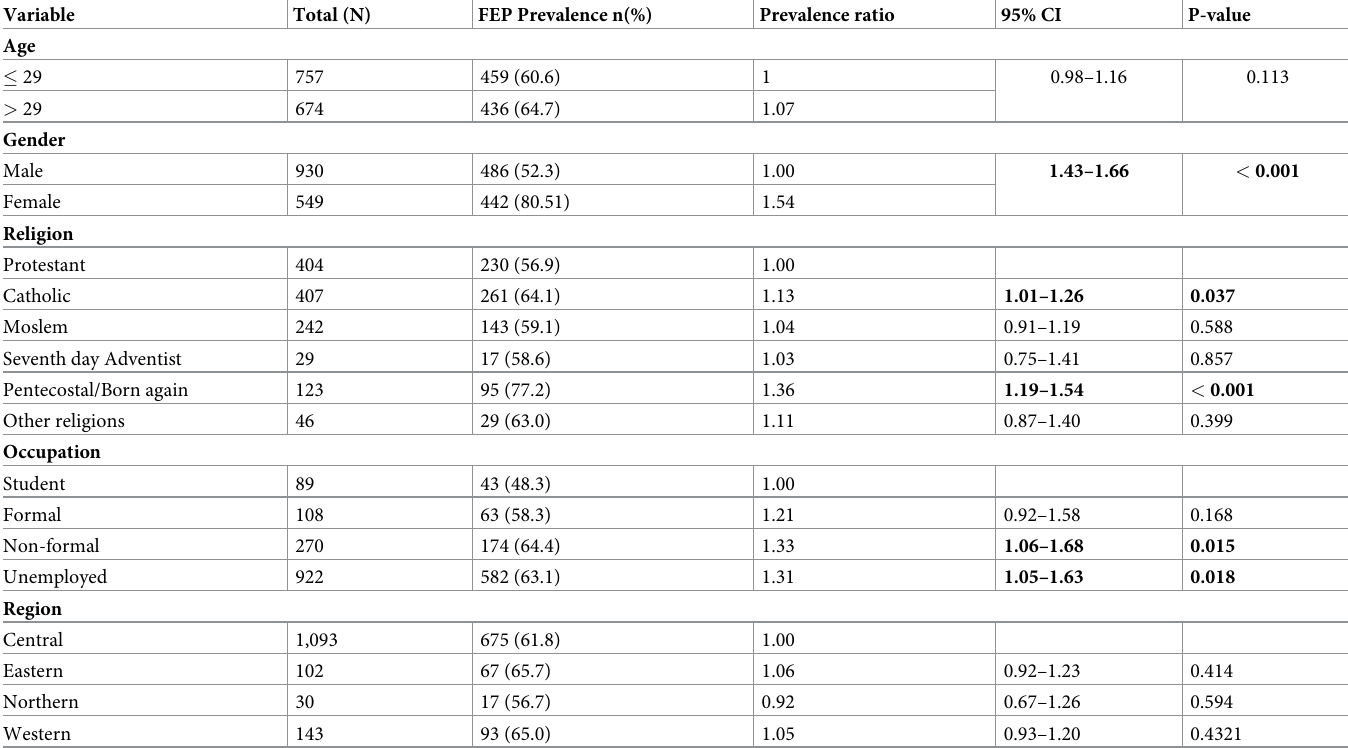
Table 3. Bivariate analysis of the association between patients with a psychosis diagnosis and different sociodemographic variables. Variable